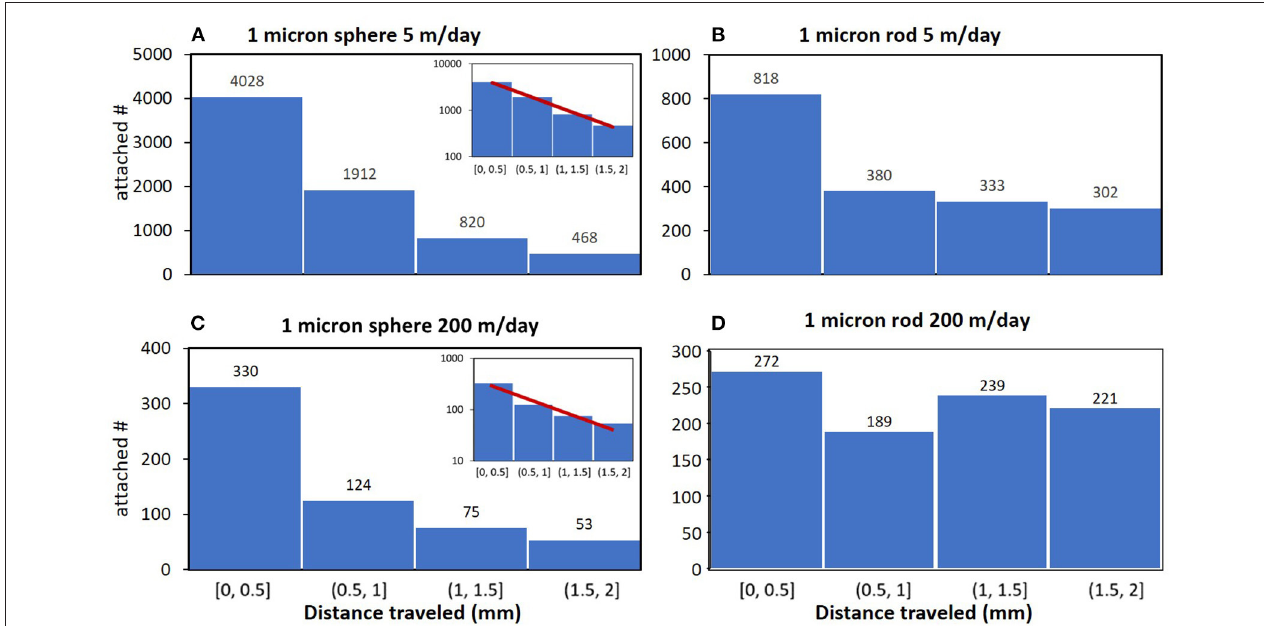
Figure 3 . The inserts in panels (A) and (C) illustrated the log-linear retention profile for spheres. The total numbers of particles injected into the systems were 27,000 for (A) , and 12,000 for (B–D) ,